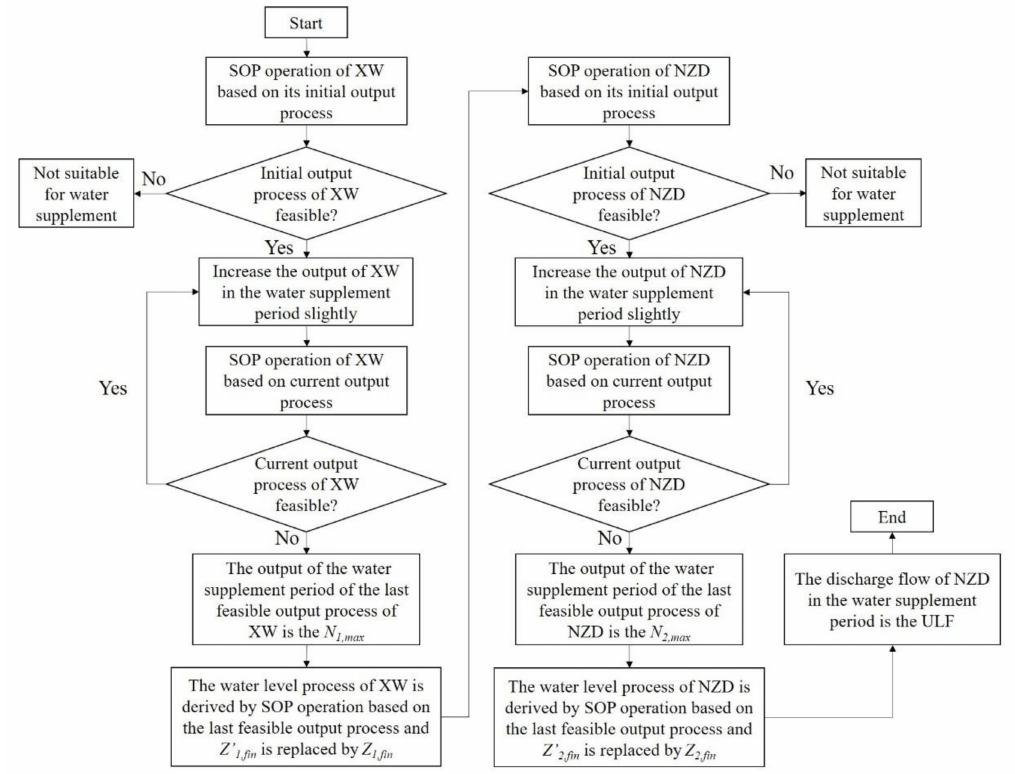
Figure 2. The calculation process of